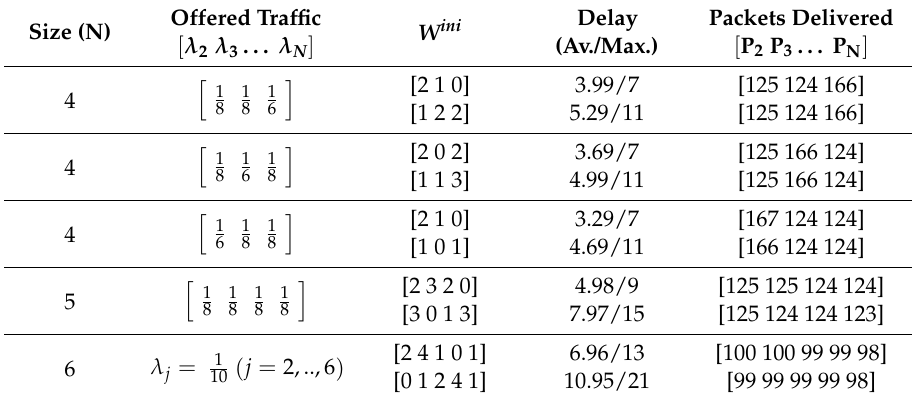
Table 2. Delay of the optimal scheduling (slots) using FIFO. Simulation time: 1000 time slots. Size (N)